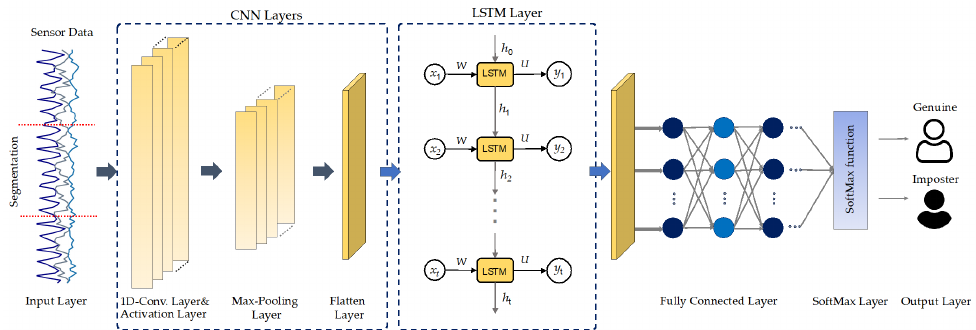
Figure 3. The DeepConvLSTM architecture for sensor-based continuous authentication proposed in this